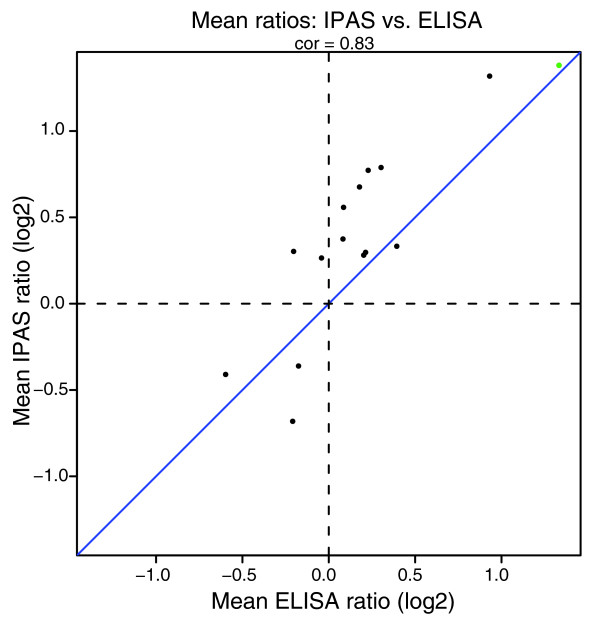
Comparison of mean ratios (1 year ET/baseline) by IPAS MS and by ELISA.